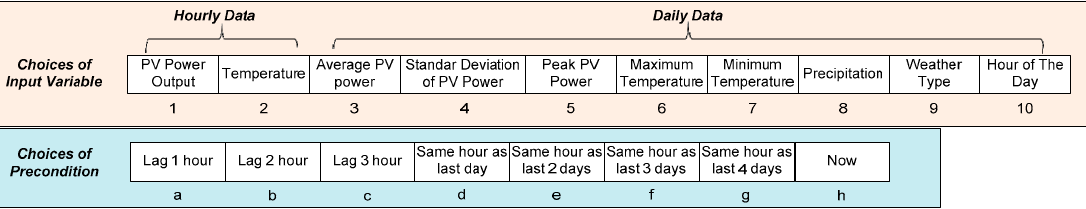
Figure 1. Potential input variables and preconditions for the convolutional neural network’s (CNN’s) predictor modeling. PV: Photovoltaic. Table 1. Correlation coefficients of the input variables.